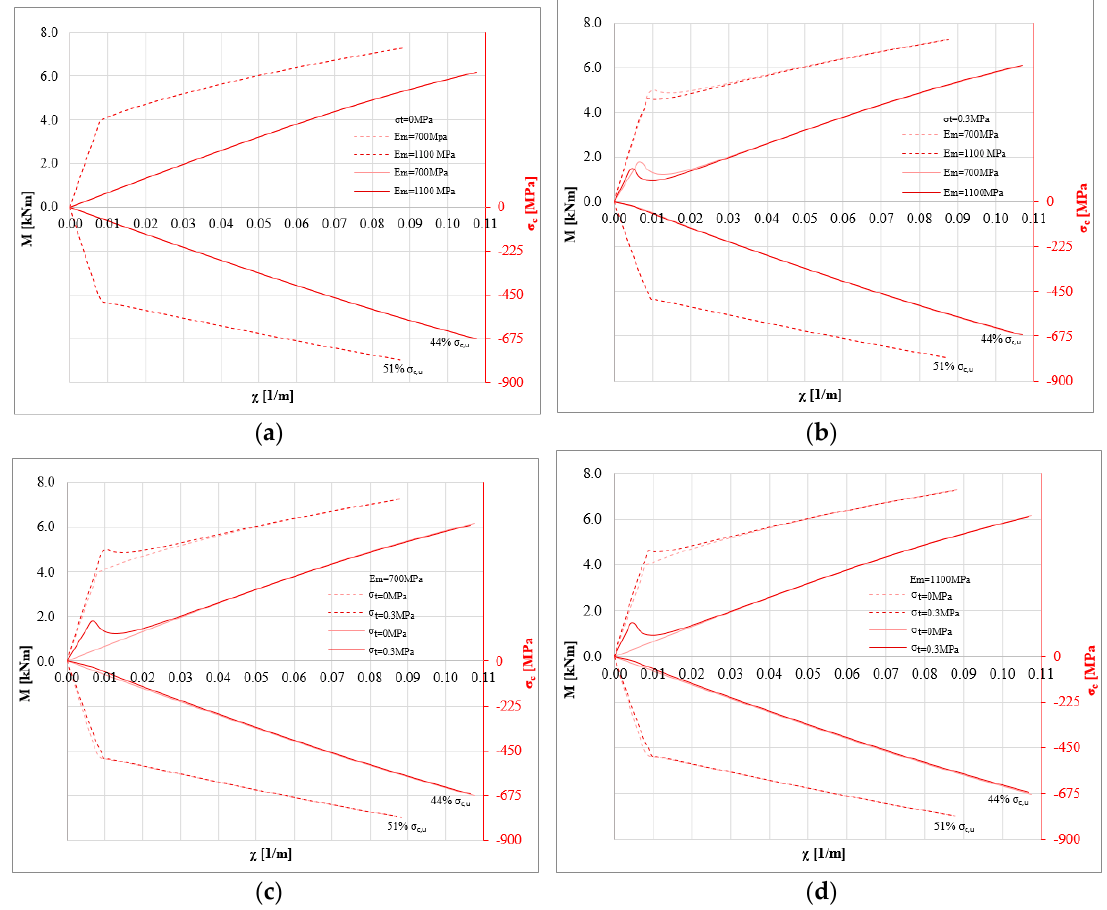
Figure 5 . M- χ and σ c,u - χ diagrams: P = 0 N, σ 0 = 1 MPa, σ t = 0 and 0.3 MPa, E m = 700 and 1100 MPa for linear (solid lines) and bi-linear (dotted lines) relationships for the strengthening system (basalt fiber): ( a ) σ 0 = 1 MPa, σ t = 0 MPa changing E m ( b ) σ 0 = 1 MPa, σ t = 0.3 MPa to changing E m ( c ) σ 0 = 1 MPa, E m = 700 MPa changing σ t ( d ) σ 0 = 1 MPa, E m = 1100 MPa changing σ t .